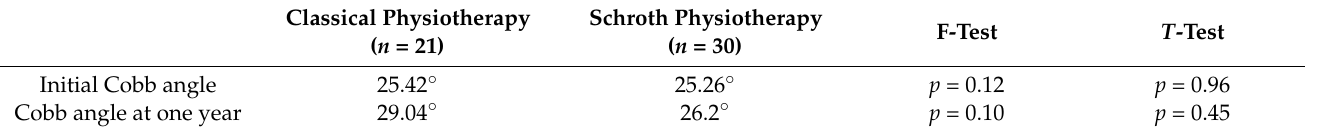
Table 4. Analysis of the Cobb angle based on each physiotherapy type, comparing initial values and results after one year.